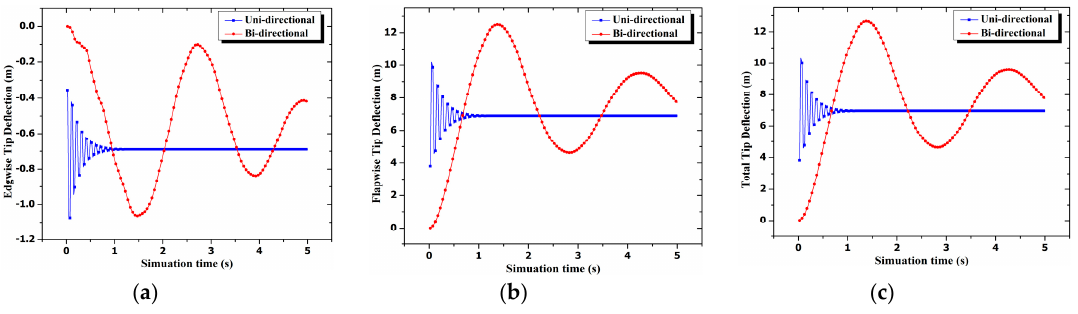
Figure 16. ( a ) Edgewise; ( b ) Flapwise; and ( c ) Total tip deflection at rated speed.